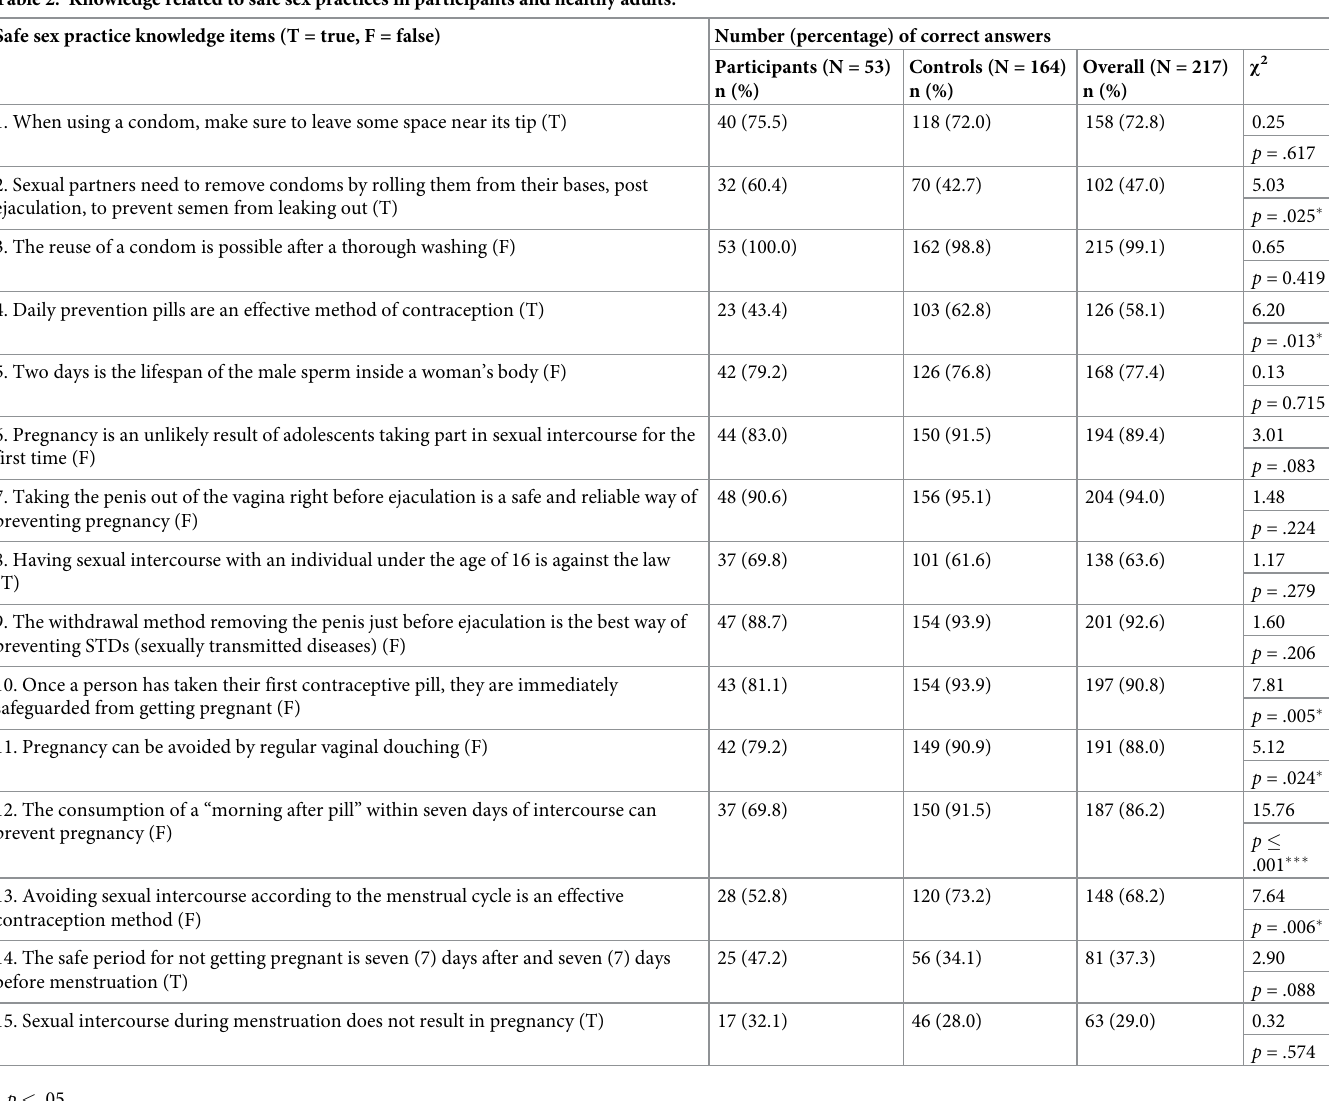
Table 2. Knowledge related to safe sex practices in participants and healthy adults. Safe sex practice knowledge items (T = true, F =